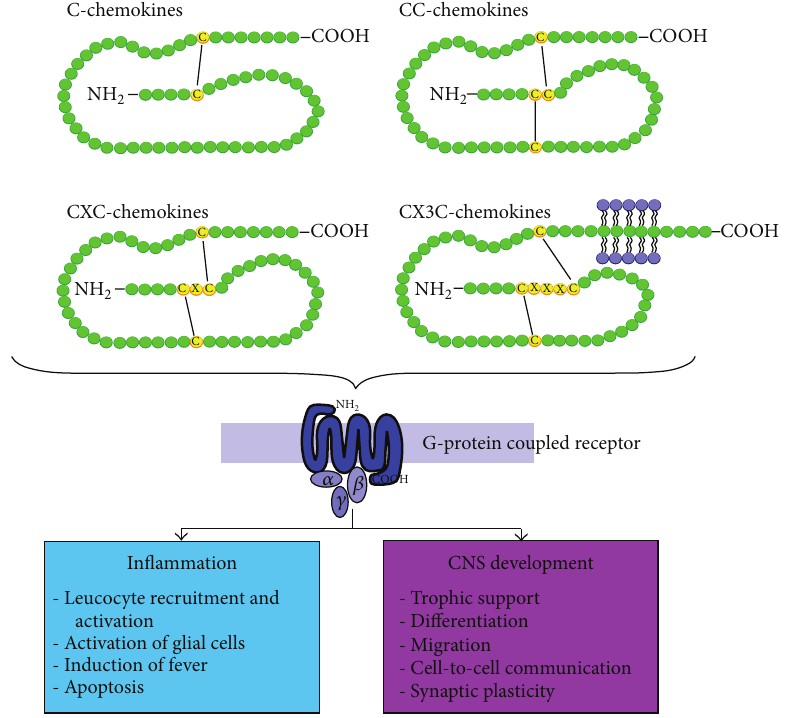
Figure 1: Chemokine classification. Based on the presence of a cysteine motif in the N-terminal region of the protein, chemokines divide into four subgroups (alpha-, beta-, gamma-, and delta-chemokines). Through activation of G-protein coupled chemokine-receptors, these chemotactic proinflammatory mediators are involved in varied pathological and physiological